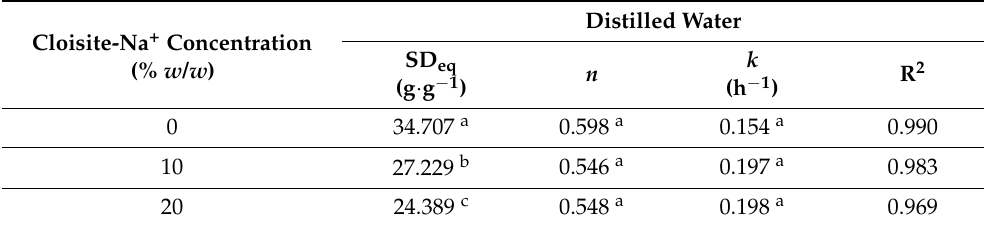
Table 4. Values of k and n obtained for different concentrations of Cloisite-Na + in the hydrogels swelled in distilled